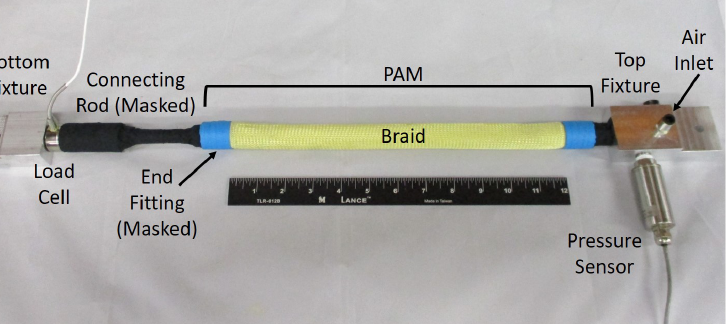
Figure 6. PAM with sensors, MTS fixtures, and masking applied prior to mounting in the MTS machine.